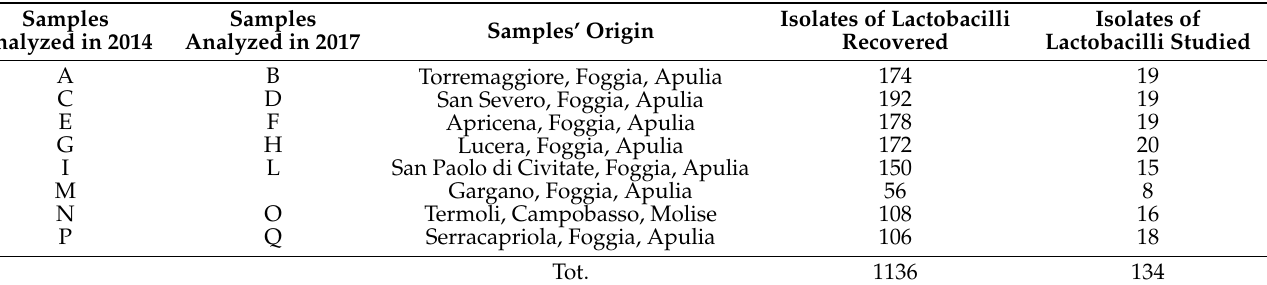
Table 1. Origin of brines’ samples analyzed throughout this research: code, year of sampling, samples’ origin, and number of lactobacilli recovered and studied for each